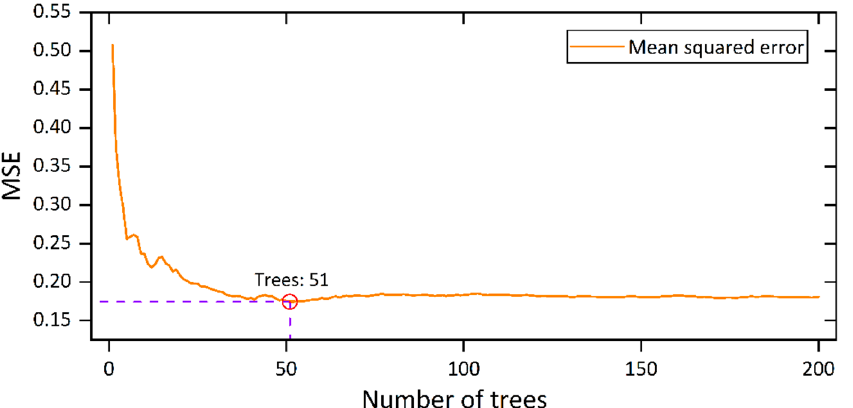
Figure 5. MSE with respect to the number of trees in a forest.